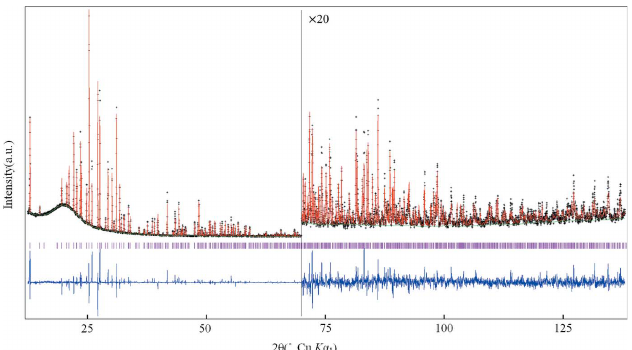
Figure 1 PXRD Rietveld refinement profiles for anhydrous Ca(ClO 4 ) 2 measured at ambient temperature. Crosses mark experimental data (black), the solid red line represents the calculated profile (red) and the solid green line is the background. The bottom trace represents the difference curve (blue) and the ticks denote the positions of expected Bragg reflections